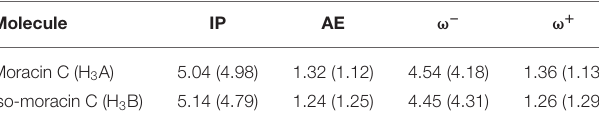
TABLE 3 | Ionization potential (IP), electron affinity (AE), electrodonating ( ω -), and electroaccepting ( ω + ) indices of moracin C and iso -moracin C in water and PE (in parentheses)